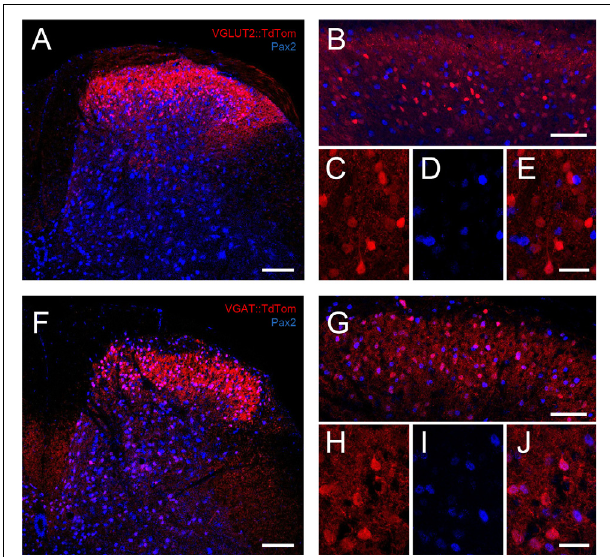
FIGURE 1 | TdTomato expression in VGLUT2:Td and VGAT:Td dorsal horn neurons. (A) Low magnification image is a maximum intensity z-projection showing the distribution of TdTom expression (red) in the dorsal horn of a spinal cord section (medial to left) from a VGLUT2:Td mouse merged with Pax2 immunolabeling (blue), which identifies inhibitory neurons. (B) A higher magnification image is a maximum intensity z-projection also showing the distribution of VGLUT2:Td and Pax2 expression within the superficial dorsal horn (SDH). Note, the lack of overlap of red and blue cell profiles. (C–E) Expanded images (from B ) show VGLUT2:Td, Pax2, and both merged, highlighting the lack of overlap and confirming VGLUT2:Td expression is limited to excitatory (Pax2 − ) profiles. (F) Low magnification image is a maximum intensity z-projection showing the distribution of TdTom expression (red) across the dorsal horn of a spinal cord section from a VGAT:Td mouse merged with Pax2 immunolabeling (blue) to identify inhibitory neurons. (G) Higher magnification image is a maximum intensity z-projection also showing the distribution of VGAT:Td and Pax2 expression within the SDH. Note, the substantial overlap. (H–J) Expanded images (from G ) show VGAT:Td, Pax2, and both merged. The overlap of fluorescent profiles confirms VGAT:Td expression is commonly found in inhibitory (Pax2+) profiles (pink; Scale bars: A,B,F,G : 100 µ m; C–E,H–J : 25 µ m).